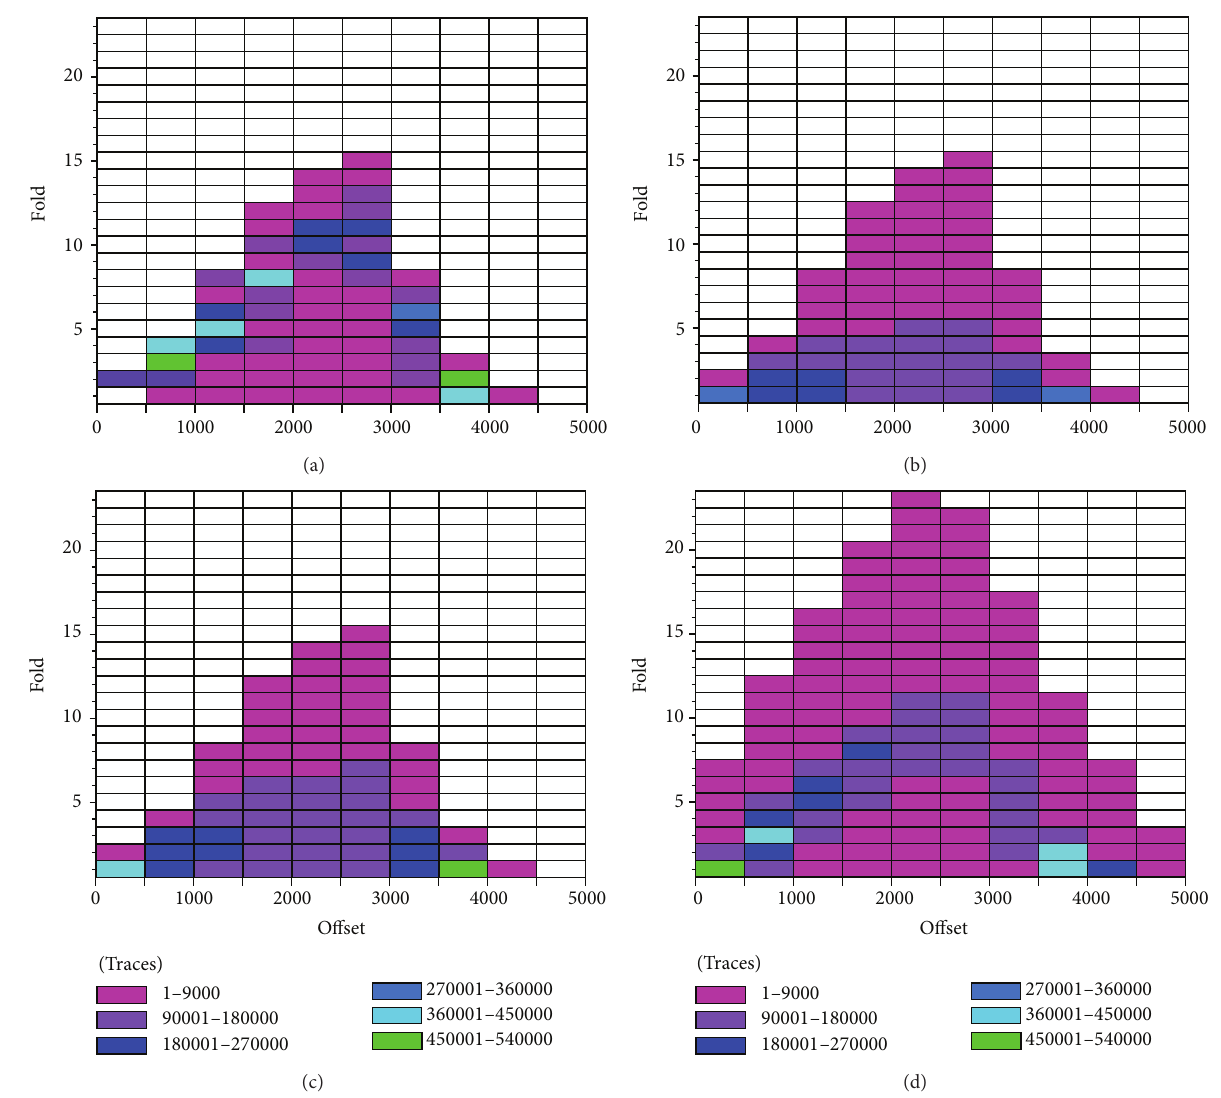
Figure 7: Fold versus offset distribution in (a) acquisition with no cultural noise, (b) acquisition with real cultural noise, (c) traditional recovery method applied on (b), and (d) new recovery strategies applied on